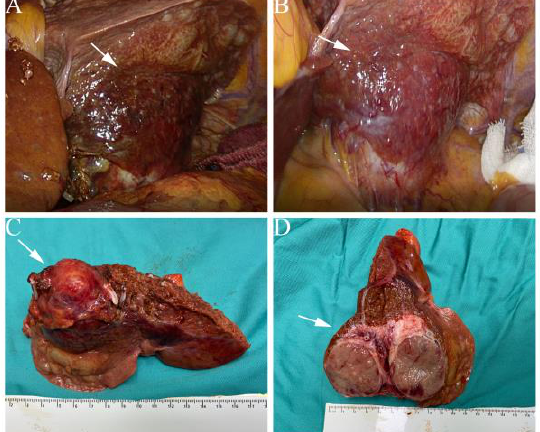
Figure 2. ( A , B ) Intraoperative images displayed a hypervascular mass in a subcapsular position. ( C , D ) Gross appearance and the cut surface of the mass. White arrows indicate the tumor.